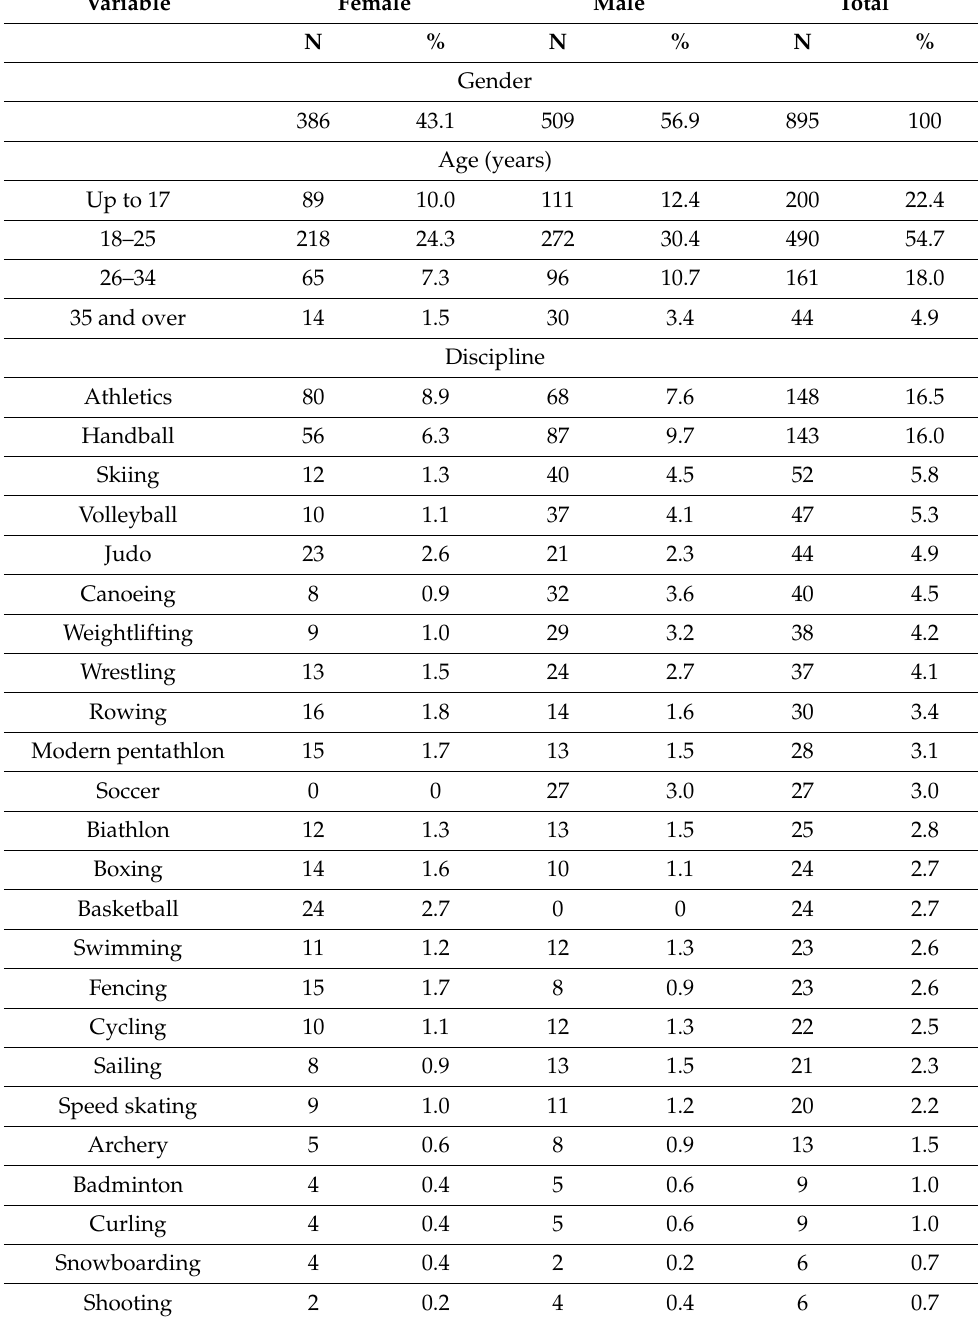
Table 1. Demographic characteristics of respondents ( n =